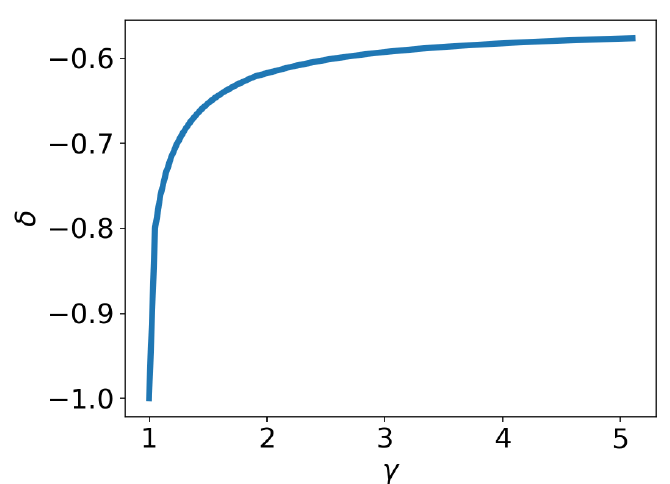
Figure 3. Shock deceleration parameter δ as a function of the adiabatic index γ for the impulsive piston problem. Values are compatible with those of Adamskii and Popov [25], as well as those in Table 12.2 of